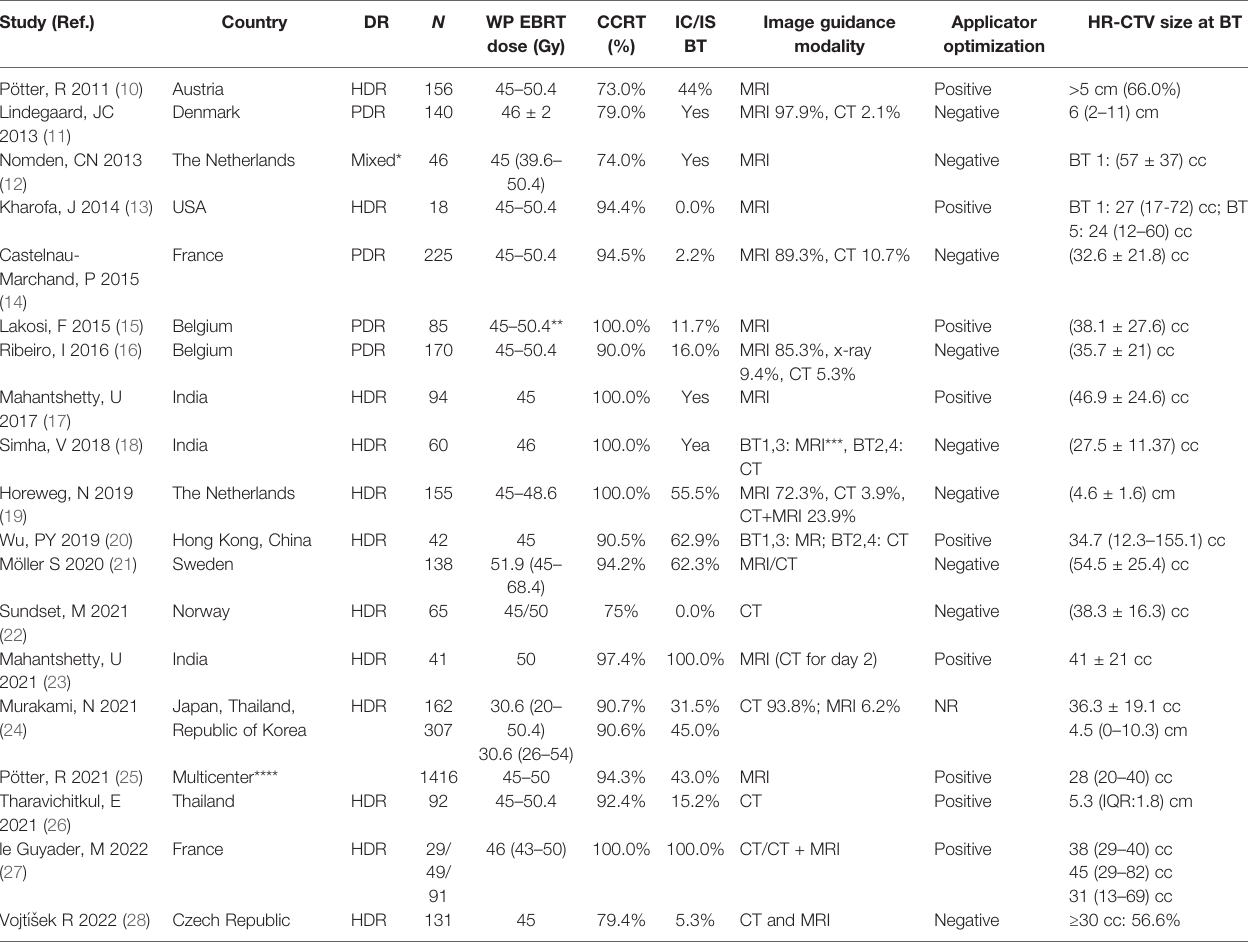
TABLE 1 | Main characteristics of the included studies: study and concurrent chemoradiotherapy. Study